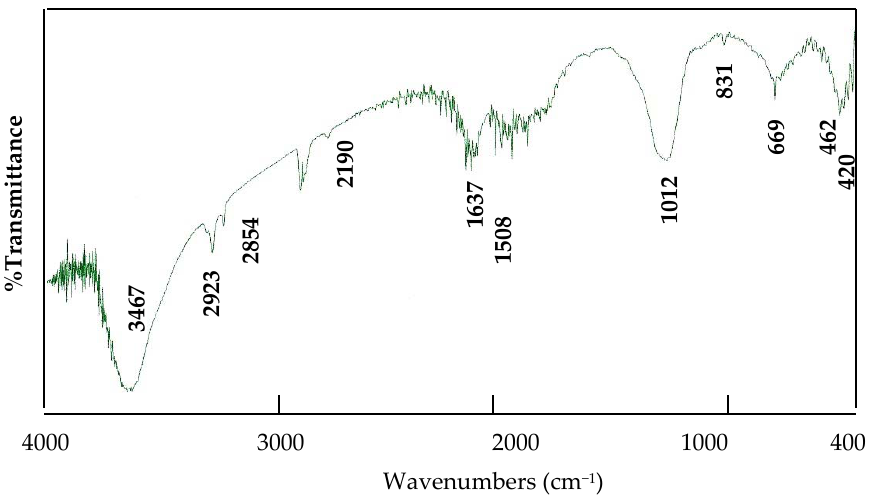
Figure 2. Infrared spectrum of the sample SiCo ‐ 1 ‐ 26.